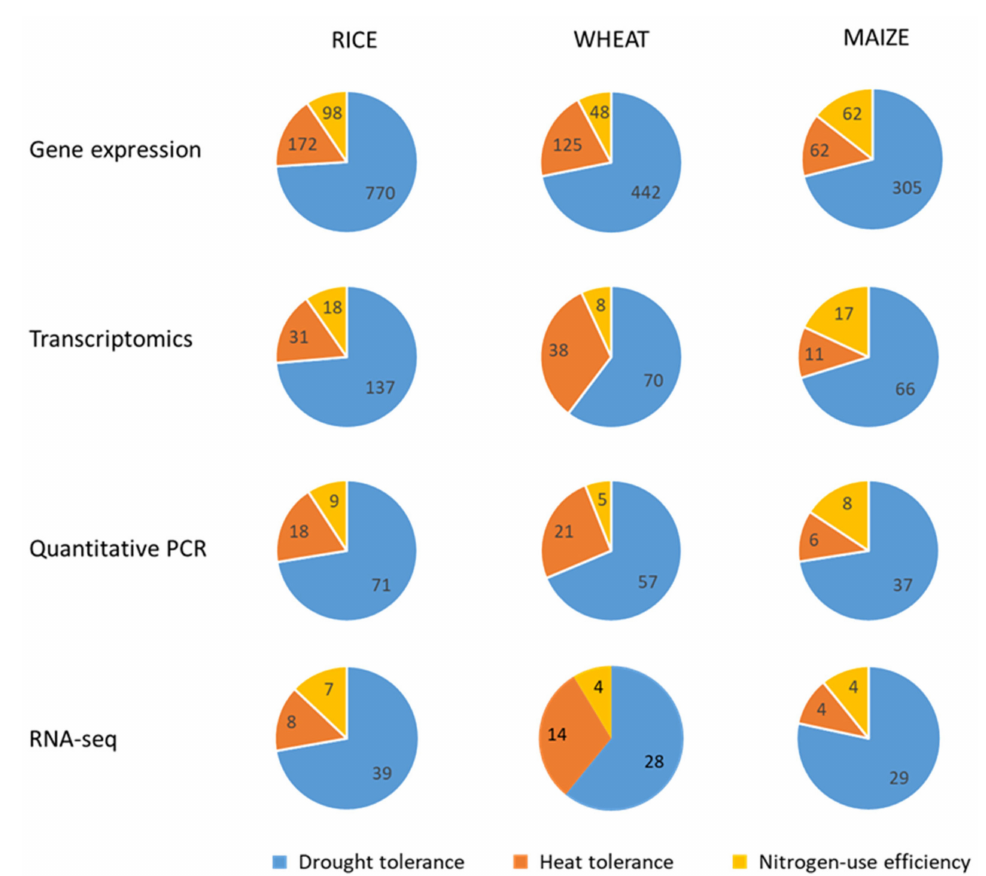
Figure 5. Relative relevance of breeding topics related to major abiotic stresses and nutrient-limiting topics in bibliographic records referring to gene expression and related tools in rice, wheat, and maize (source: Web of Science database, all years available; accessed on 15 December